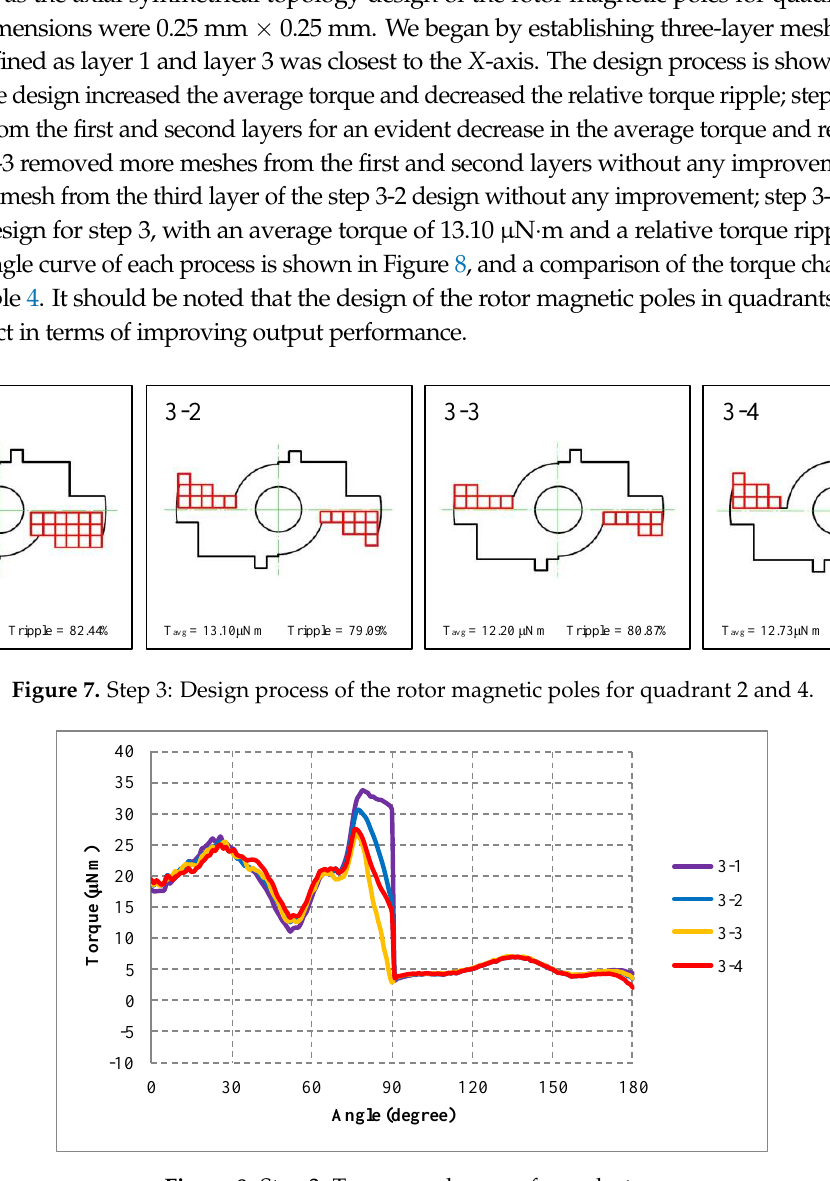
Figure 8. Step 3: Torque-angle curve for each step.